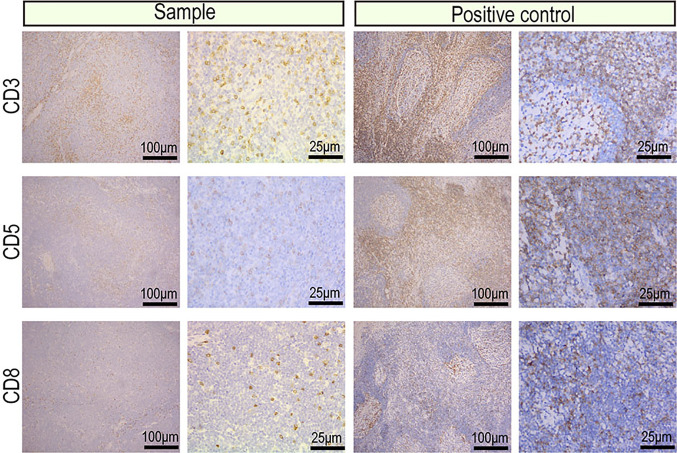
Images of the reactive T cells surrounding tumor cells from the primary renal MALT lymphoma (scale bar: 100μm, 25μm). Representative IHC images for CD3, CD5, and CD8 which were markers of reactive T cells.